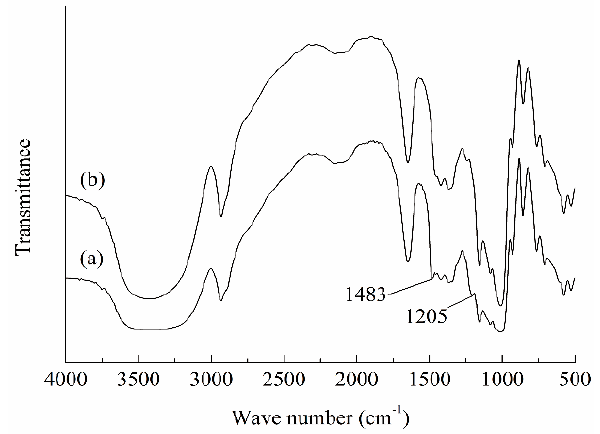
Figure 1. Fourier transform infra-red (FTIR) spectra of QHOTS (a), and OTS (b).